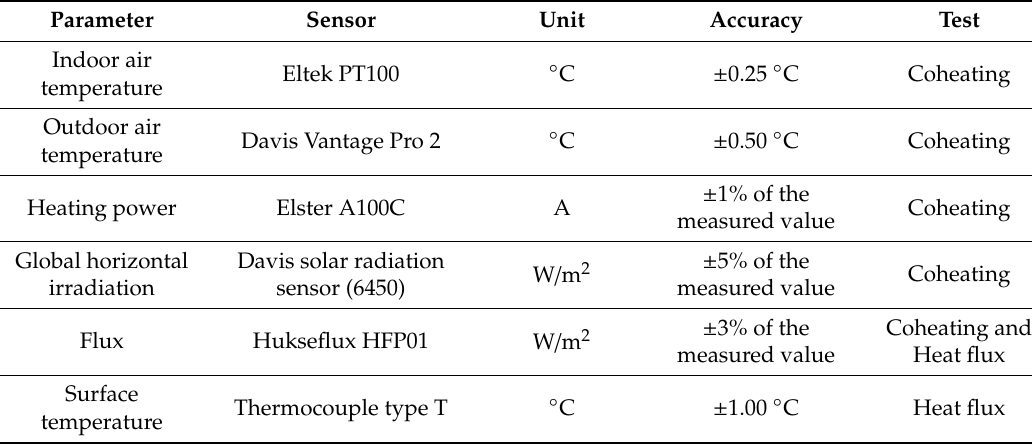
Table 4. Sensor specifications.